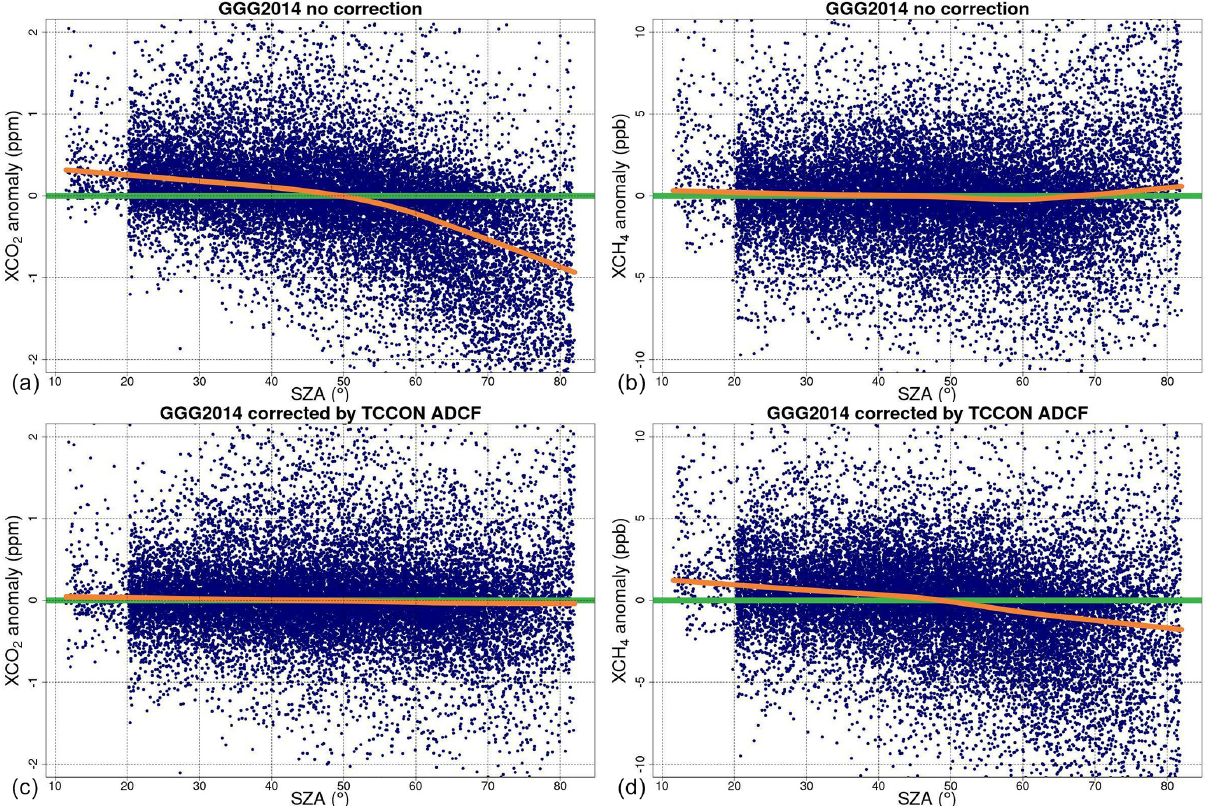
Figure 4. Daily XCO 2 and XCH 4 anomalies of the EM27/SUN (ta) measured in Toronto from 2017 to 2021 and during the road trip in 2018 vs. solar zenith angle using GGG2014. (a, b) No ADCF applied. (c, d) TCCON ADCF applied. The orange line is the Lowess curve fit. The horizontal green line is the y = 0